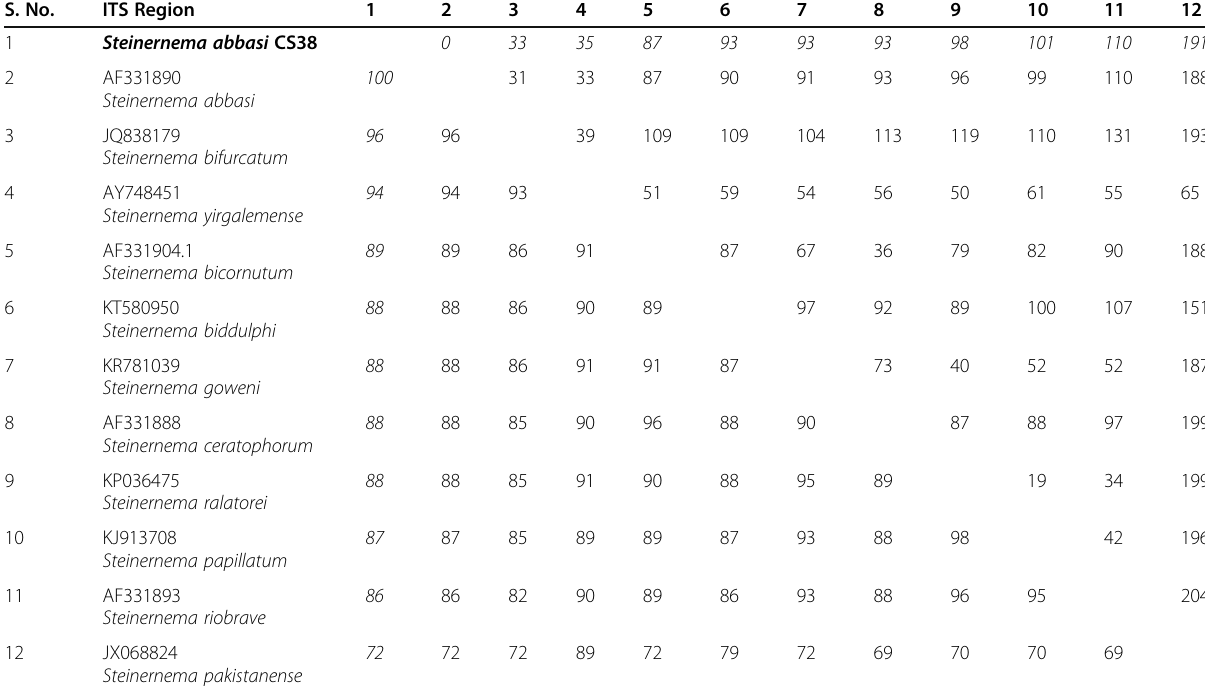
Table 4 Pairwise distances of the ITS region between Steinernema species from the “ bicornatum ” group S. No. ITS